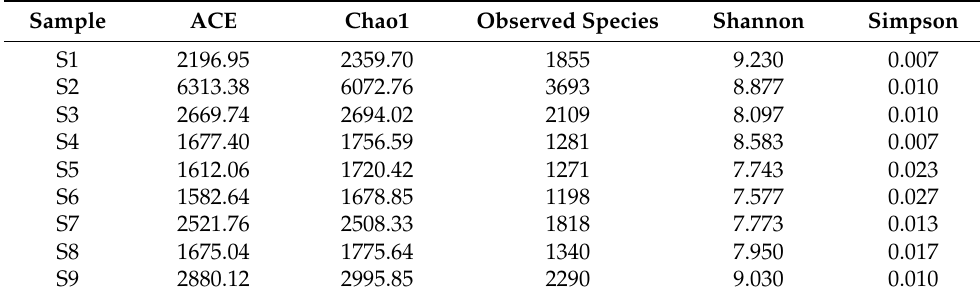
Table 1. The α -diversity index levels of bacterial community.